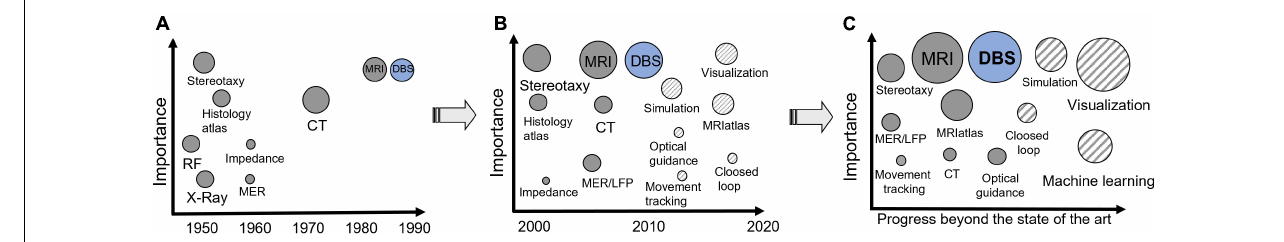
FIGURE 9 | (A) Supporting techniques for DBS implantation and their approximate time of introduction in functional neurosurgery. (B) Progress during the last 20 years and state of the art. (C) Stipulated progress beyond the state of the art. The size of the circles shows the importance/use today. The striped circles represent novel